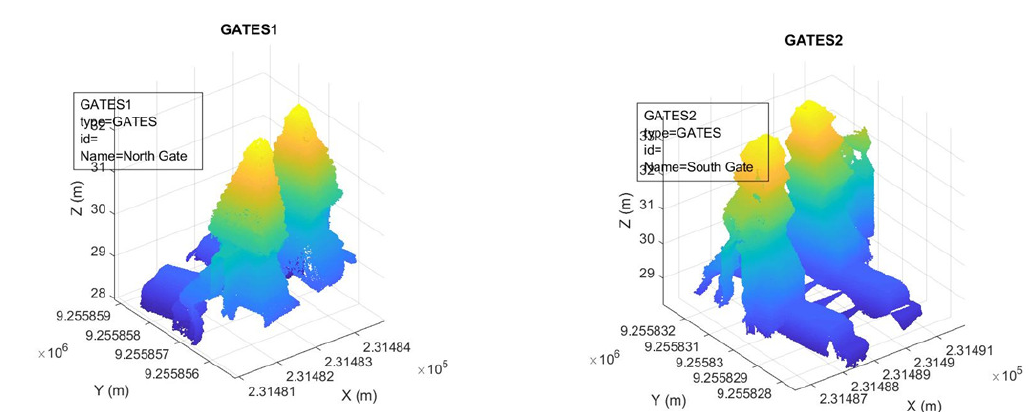
Figure 5. Result of the segmentation and semantic annotation process for each object for the class